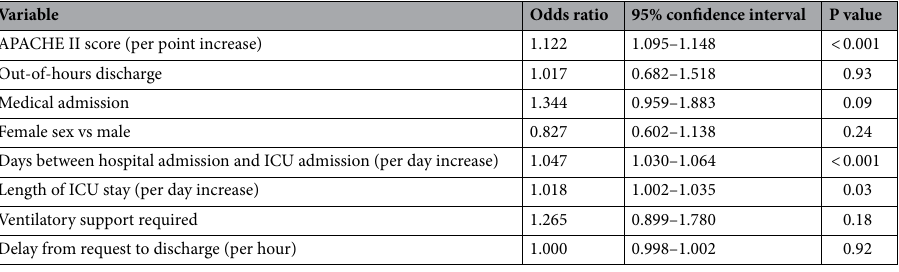
Table 2. Multiple logistic regression model showing associations between predictor variables and the outcome variable of in-hospital mortality, in patients discharged alive from our intensive care unit (ICU) over a 3-year period (n =